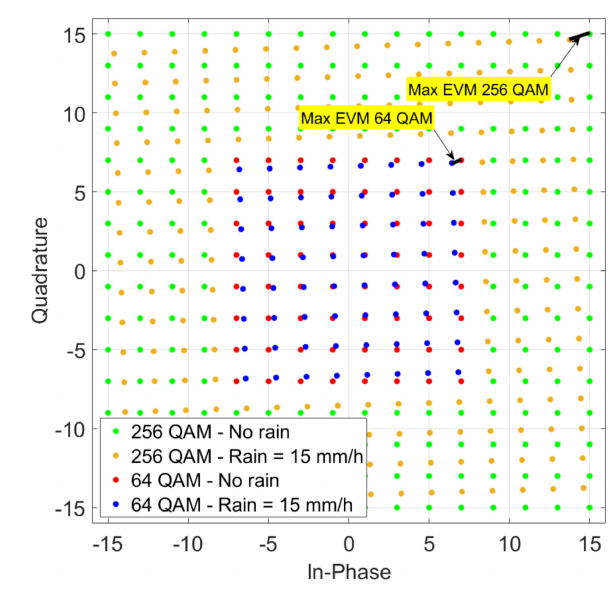
Figure 6. Comparison of 64 QAM and 256 QAM constellation diagrams at a carrier frequency of 28 GHz for 200 m wireless link for di ff erent rainfall